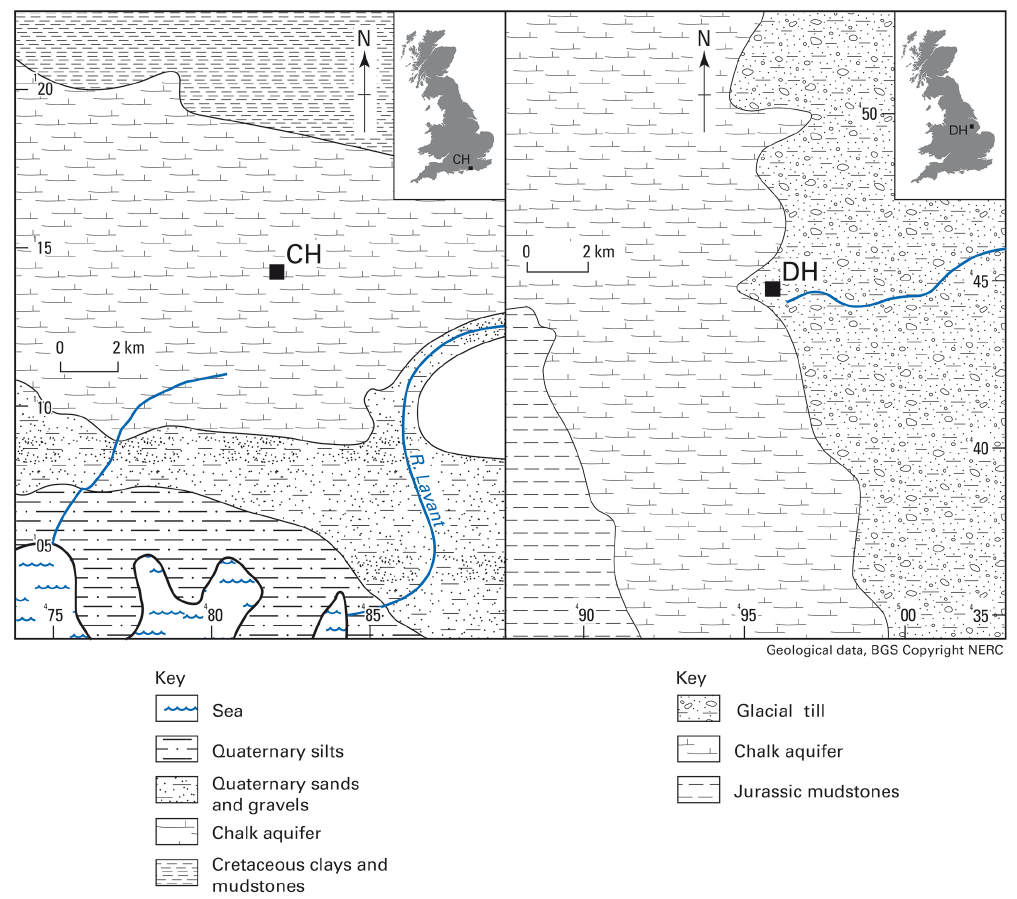
Figure 1. Location of the CH and DH observation boreholes, local geological setting, coastline and surface water courses.